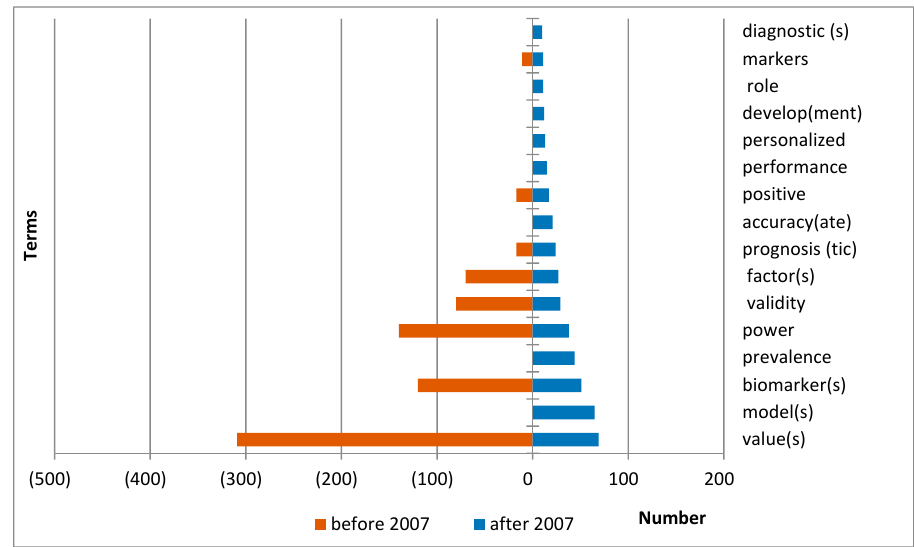
Figure 6. The frequency of occurrence of terms in the vicinity of the derivative “predictive” over the past decade.